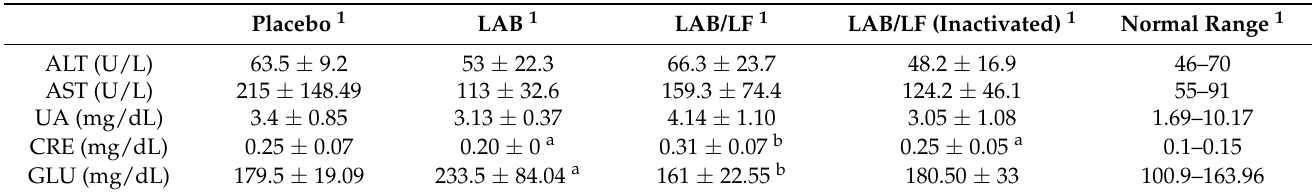
Table 3. Serum levels of aspartate transaminase (AST), alanine aminotransferase (ALT), glucose (GLU), uric acid (UA), and creatinine (CRE) in DIO mice supplemented with a placebo or one of three probiotic mixtures. The results are presented as means ±